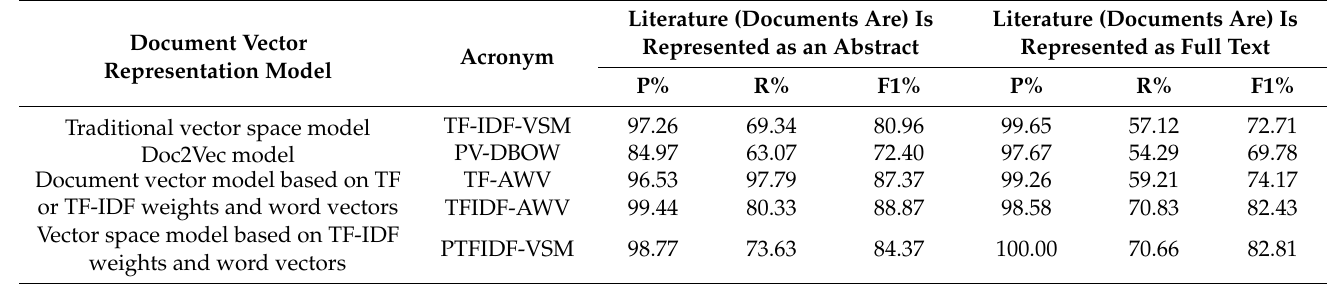
Table 5. Performance of implicit citation sentence detection based on various document representation